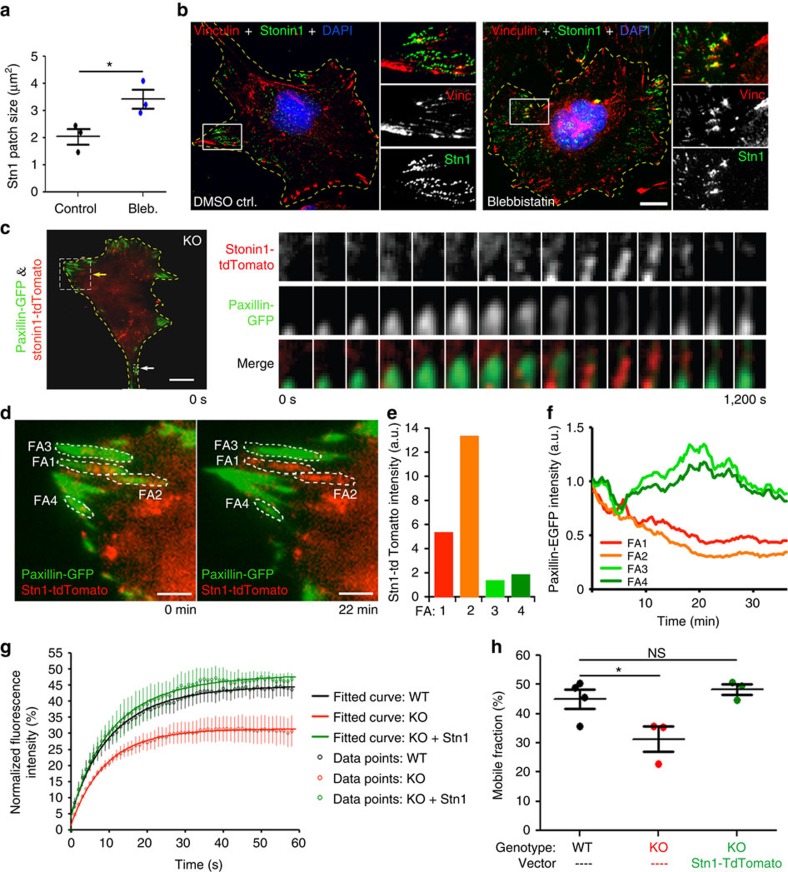
Stonin1 regulates FA dynamics.(a,b) Effect of blebbistatin on Stonin1 in MEFs. (a) Blebbistatin (50 μM for 30 min) induces larger Stonin1 patches. Quantification of absolute size of Stonin1-positive structures in control and blebbistatin-treated cells (data are depicted as mean±s.e.m., N=3, n=20–28 per experiment, unpaired two-tailed Student's t-test, *P<0.05). (b) Acute blebbistatin treatment (25 μM for 5 min) increases the co-localization of Stonin1 with the FA marker vinculin. Blebbistatin- or dimethylsulphoxide (DMSO)- (=control) treated cells were fixed and stained with vinculin- and Stonin1-specific antibodies. Scale bar, 25 μm. (c) Stonin1 accumulates at disassembling FAs. Images derived from live-cell TIRF time-lapse movie of Stonin1−/− MEF transfected with Stonin1-tdTomato and Paxillin-GFP (60 min movie with 20-s intervals; pixels were smoothened by ImageJ). Left: overview of an imaged cell at the begining of the movie. Scale bar, 25 μm. Right: time series of the boxed area indicated with a white arrow. (d–f) High levels of Stonin1 correlate with FA disassembly, while low Stonin1 levels are found in stable FAs. (d) Enlargement of the boxed area indicated by a yellow arrow in c at 0 min (left) and 22 min (right) (see also Supplementary Movie 1). Scale bar, 6.25 μm. (e) Quantification of Stonin1-tdTomato fluorescence intensity per area (background subtracted) summarized over 35 min within leading edge FAs #1–4 as defined by Paxillin-EGFP signal (see outline). (f) Quantification of the Paxillin-EGFP fluorescence intensity over time as a measure for FA stability for FAs #1–4. (g,h) Slowed FA dynamics in the absence of Stonin1. (g) Curves depicting % fluorescence recovery after photobleaching (FRAP) for Paxillin-EGFP-transfected WT and Stonin1−/− MEFs. Original data points±s.e.m. are shown (open circles) as well as fitted curves (solid lines). Re-expression of Stonin1-tdTomato rescued the decreased recovery in Stonin1−/− MEFs. (h) Quantification of the recovered, that is, mobile fraction of Paxillin-EGFP molecules based on the exponential fit of the FRAP data (data are given as mean±s.e.m., N=4 for WT, N=3 for KO and rescue, one-way analysis of variance followed by Dunnett's post-test, *P<0.05). NS, not significant.